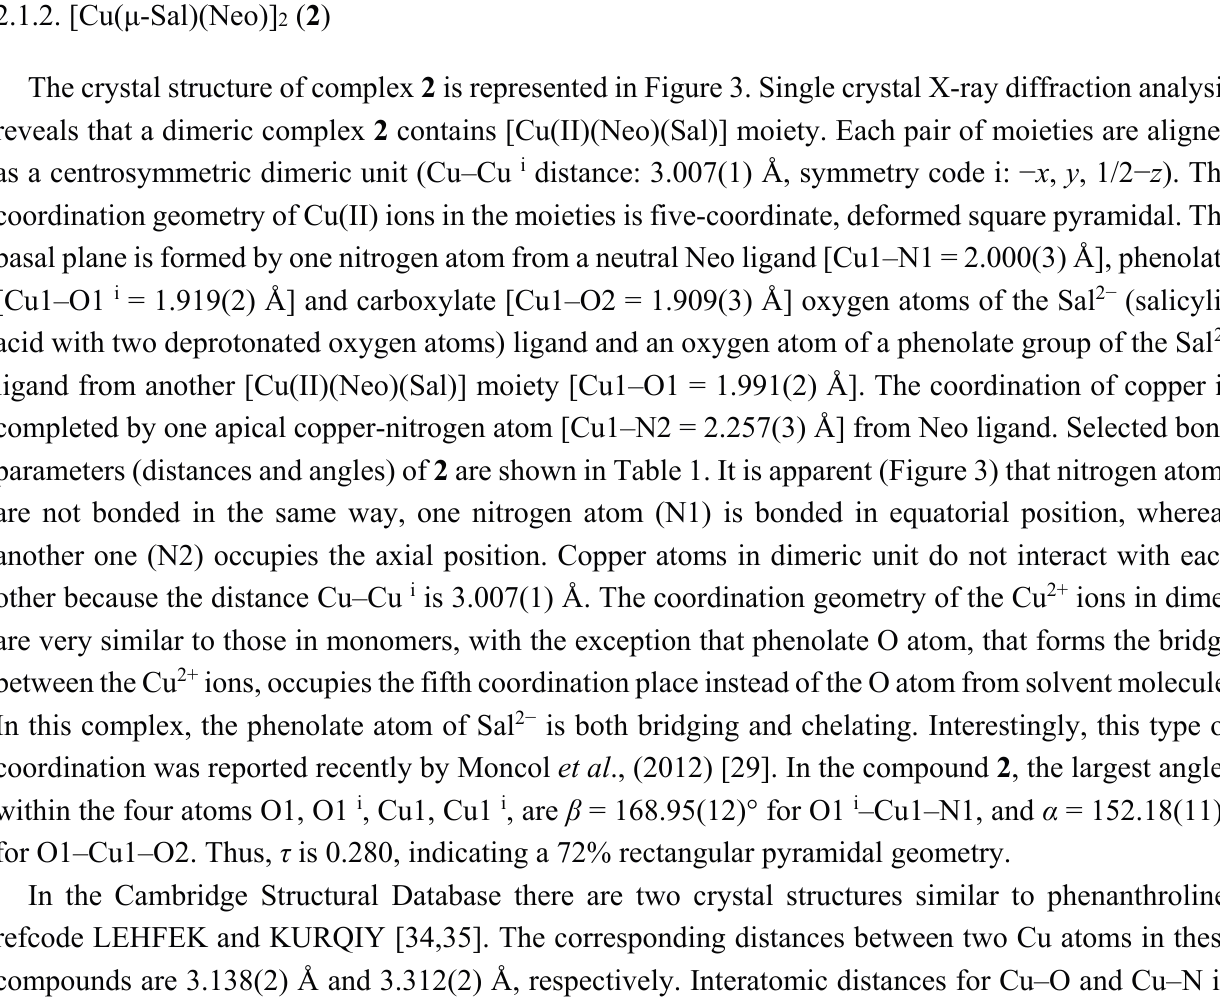
Figure 2. 1D chain formed by hydrogen bonds in complex 1